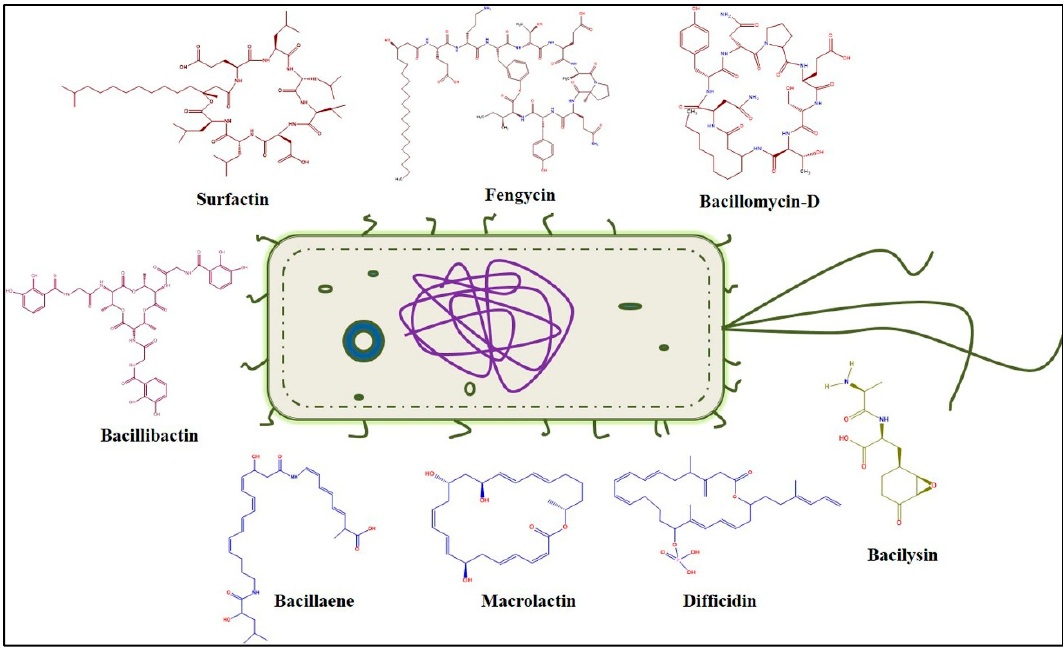
Figure 1. Antimicrobial compounds synthesized by B . velezensis . The compounds highlighted in red are synthesized by non-ribosomal peptide synthetases (NRPSs); blue compounds are synthesized by polyketide synthase (PKSs); green color compound bacilysin is synthesized by a ribosome independent pathway.